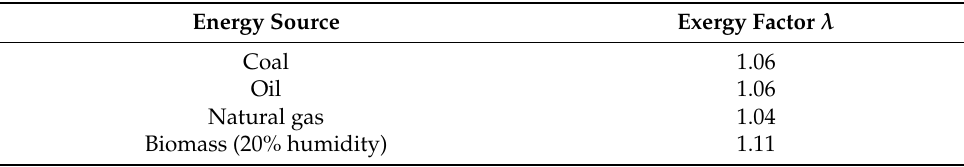
Table 1. Values of the exergy factor λ